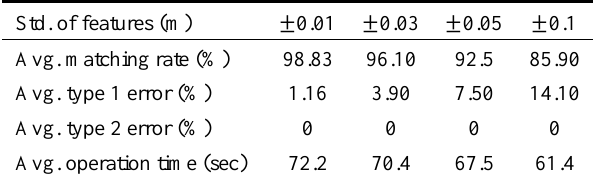
Table 1. the matching performance.